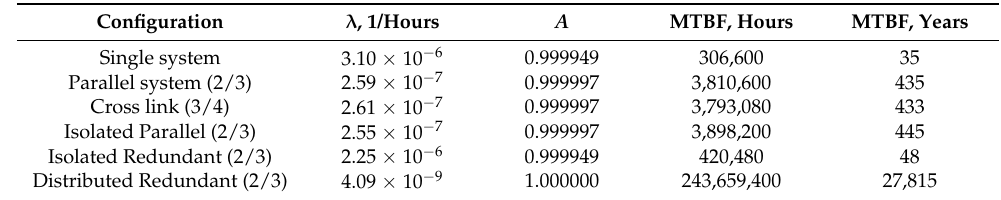
Figure 6. An example of an RBD diagram for a PS configuration. Table 1. Reliability indicators for configurations of continuous electrical power supply systems with dynamic UPS.